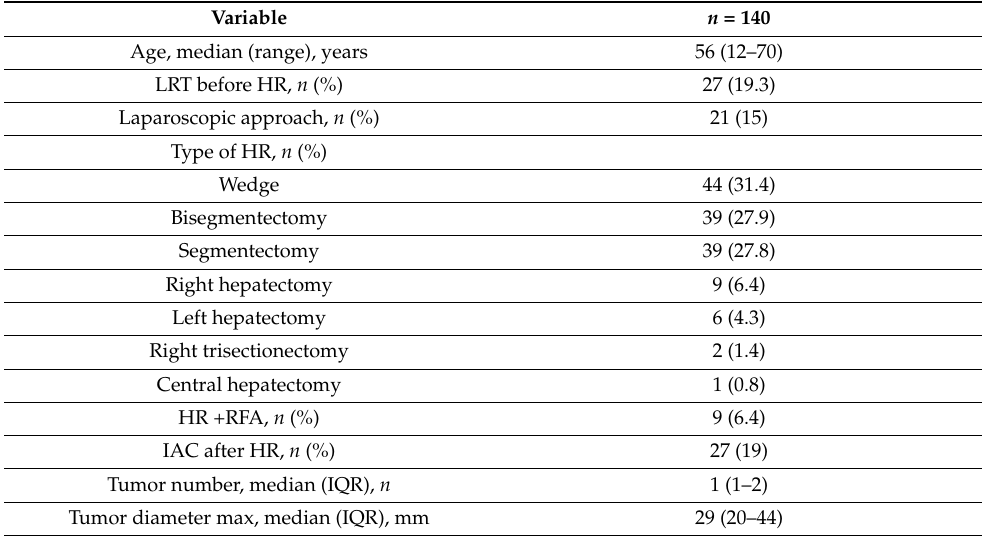
Table 1. Characteristics of patients at the time of hepatic resection